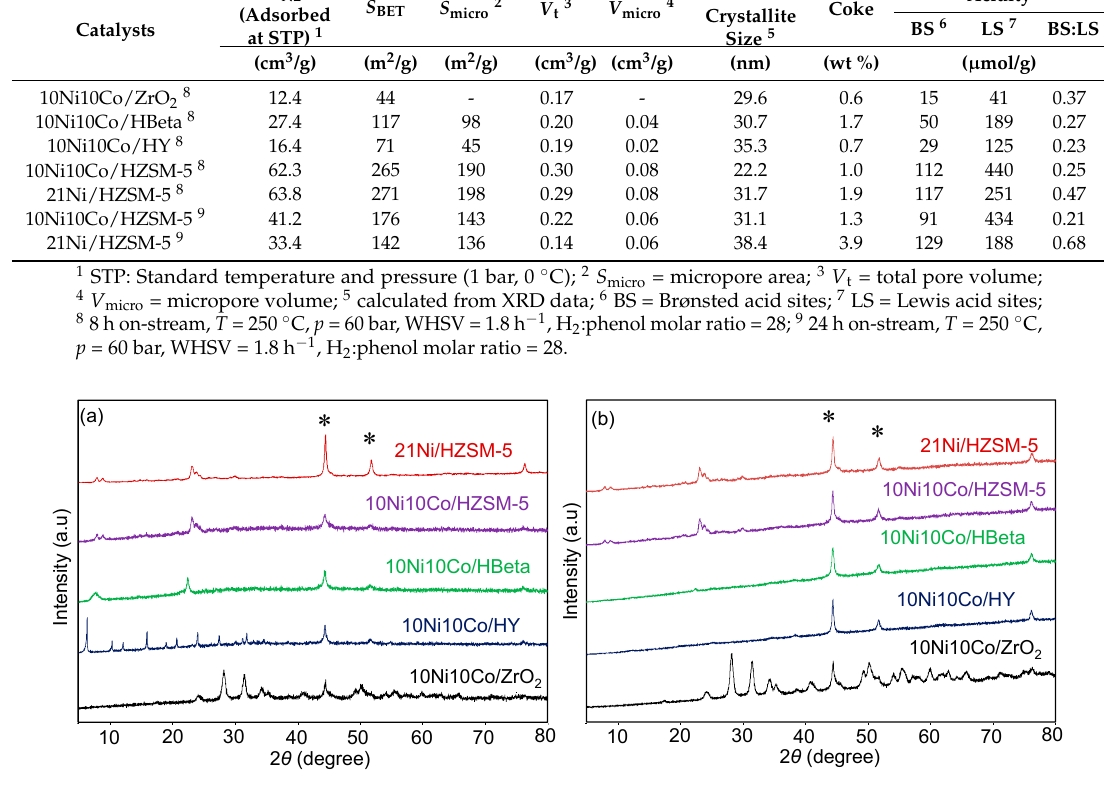
Figure 2. X-ray powder diffraction (XRD) patterns of pre-reduced ( a ) and spent catalysts ( b ) from HDO Figure 2. X ‐ ray powder diffraction (XRD) patterns of pre ‐ reduced ( a ) and spent catalysts ( b ) from runs in the continuous reactor ( T = 250 ◦ C, p = 60 bar H 2 , WHSV = 1.8 h − 1 , 3 wt % phenol in H 2 O, HDO runs in the continuous reactor ( T = 250 °C, p = 60 bar H 2 , WHSV = 1.8 h − 1 , 3 wt % phenol in H 2 O, H 2 :phenol molar ratio = 28, 8 h on-stream; * 2 θ = 44.4 ◦ and 51.7 ◦ (powder diffraction file (PDF) for H 2 :phenol molar ratio = 28, 8 h on ‐ stream; * 2 θ = 44.4° and 51.7° (powder diffraction file (PDF) for Ni ‐ Ni-Co Co [01 ‐ 074 ‐ 5694]). Table 2. Textural and acidic properties of the spent catalysts.